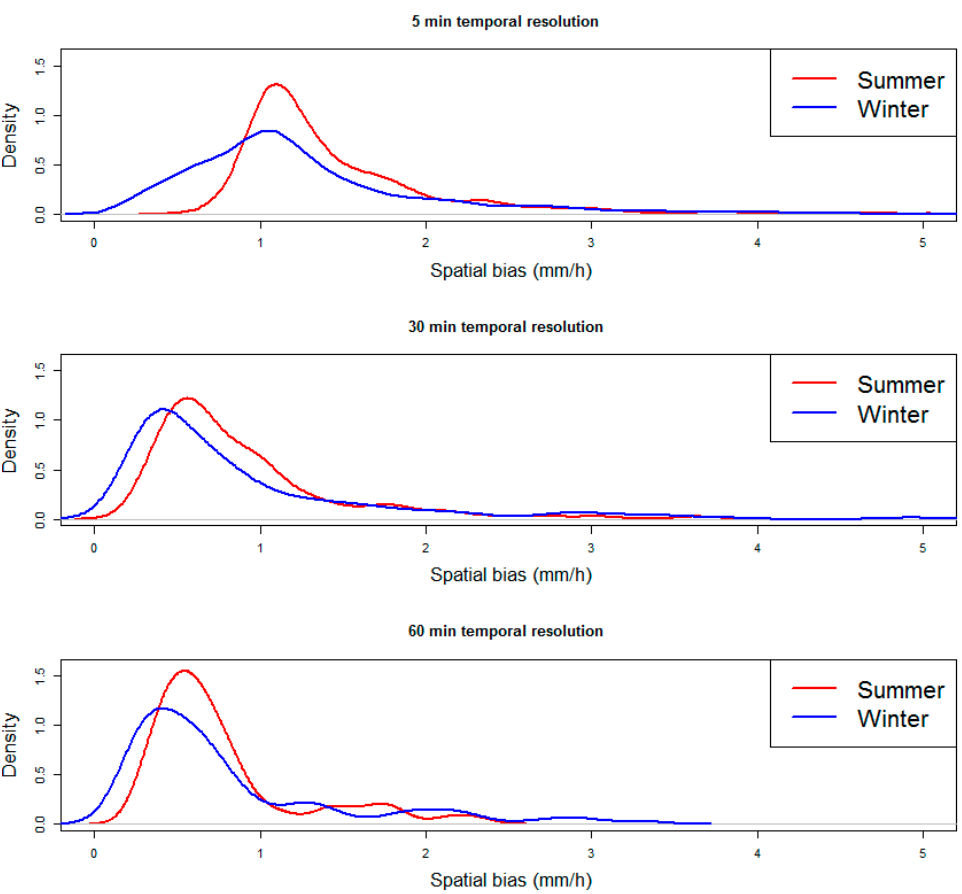
Figure 5. Density distributions of spatial bias in radar data by season and temporal resolution (in mm/h).